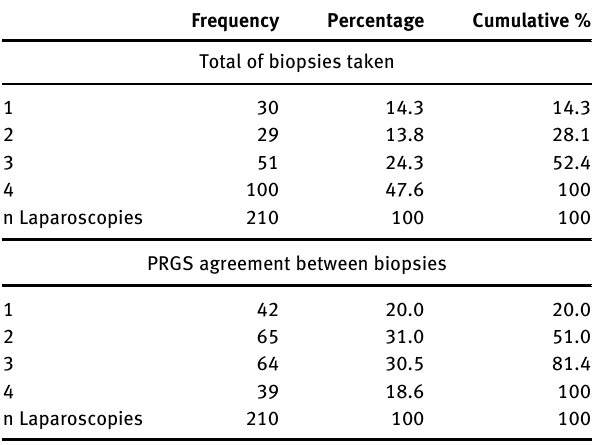
Table  : Number of biopsies available and PRGS agreement between